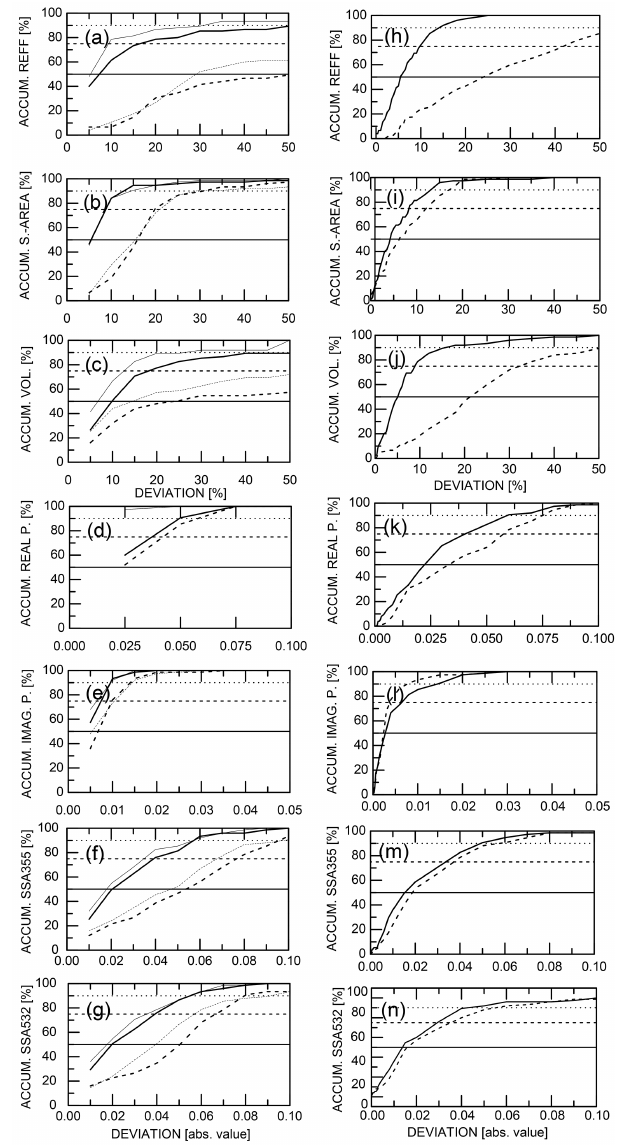
Figure 11. Accumulative distribution of inversion results for TRO- POS/UH algorithm (left panel) and UP algorithm (right panel). TROPOS/UH algorithm: results are shown for the constraint that the real part can be extracted to an accuracy of 0.05 (solid thin line) and 0.1 (solid thick line), according to Chemyakin et al. (2014) and the data error is 0%. Results for the data error of 15% are shown too (0.05 accuracy as thin dashed line and 0.1 accuracy as thick dashed line). UP algorithm: results are shown for the noiseless case (solid thick line) and for the data error of 15% (thick dashed line) with- out any constraint for the real part in both cases. In the case of (a, h) effective radius, (b, i) surface area and (c, j) volume concentra- tion we show the accumulative sum in dependence of the deviation in percent from the true results. In the case of the (d, k) real part, (e, l) imaginary part, and single-scattering albedo at (f, m) 355nm and (g, n) 532nm we show absolute deviations. The solid horizontal line shows the 50% level (accumulative sum). The dashed horizon- tal line shows the 75% level, and the dotted horizontal line shows the 90%